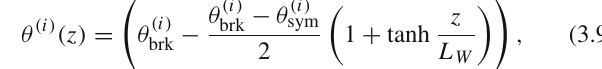
for ω i = ω 1 (red), ω 2 (blue) and ω CP (green), versus